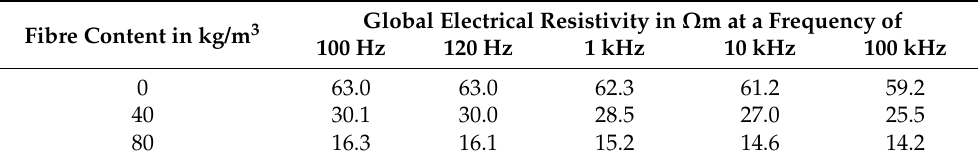
Table A39. Results of the resistivity measurements of the concrete mixture 32-60-300-00 after storage in H 2 O for 91 days for the investigations of possible leaching effects.